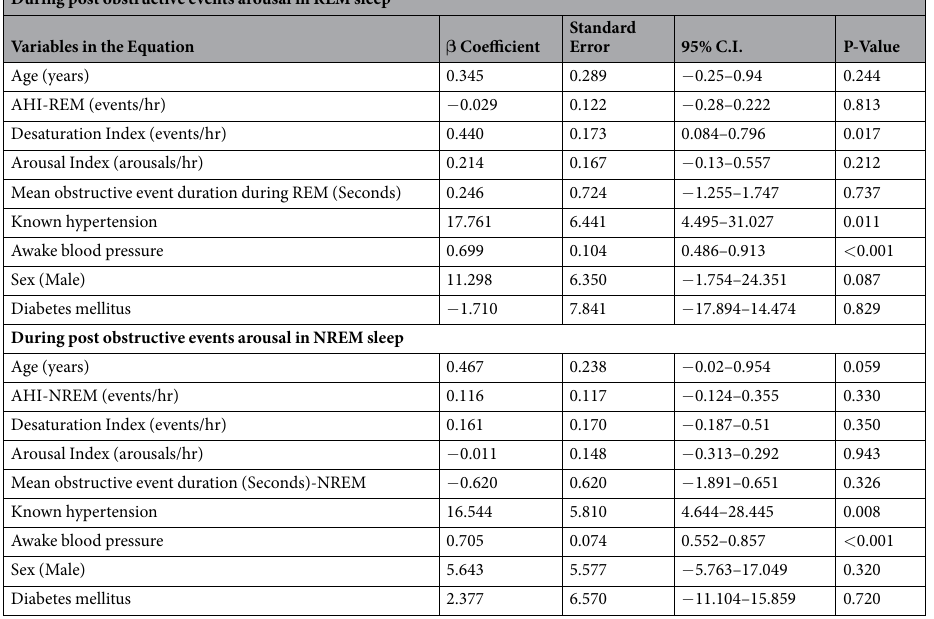
Table 7. Linear regression analysis to predict systolic blood pressure during post-events arousal REM (n = 32). (Enter